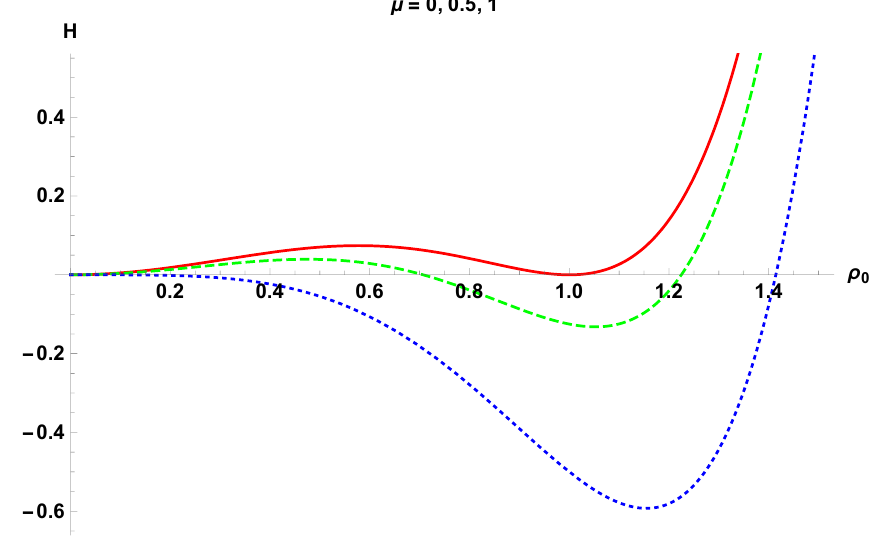
Figure 1 . Light-cone Hamiltonian as a function of the graviton’s size (cid:26) 0 . The plots are in units where M = P = ! = m = 1. The three curves correspond to three di(cid:11)erent values of the deformation parameter: (cid:22) = 0 (red solid), (cid:22) = 0 : 5 (green dashed) and (cid:22) = 1 (blue dotted). Notice that the plots are for a speci(cid:12)c (arbitrary) value of the modulus y 0 . Changing the value of the modulus, and since the Light-cone Hamiltonian does not depend on y 0 , produces a series of degenerated vacua distributed one next to the other along the extra (moduli) axis. For values of the deformation that (cid:22) (cid:21) 1 the potential has the shape of a Mexican hat but with the periodic direction decompacti(cid:12)ed and this signi(cid:12)es the spontaneous breaking of the conformal